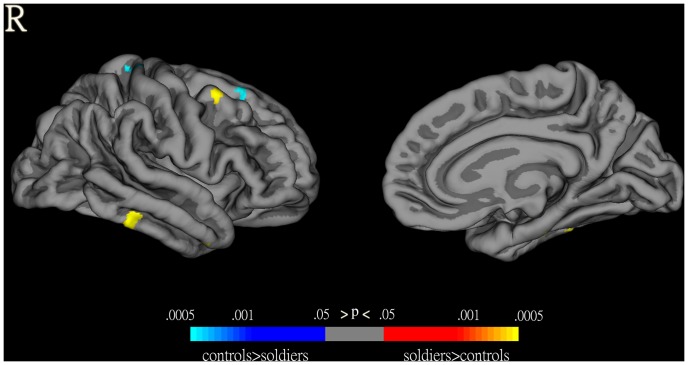
VBM-identified differences in gray matter volume projected on FreeSurfer-derived cortical surface.These maps show significant gray matter volume differences between HA immigrants and SL controls (compare these with the FreeSurfer analyses in Figure 2).